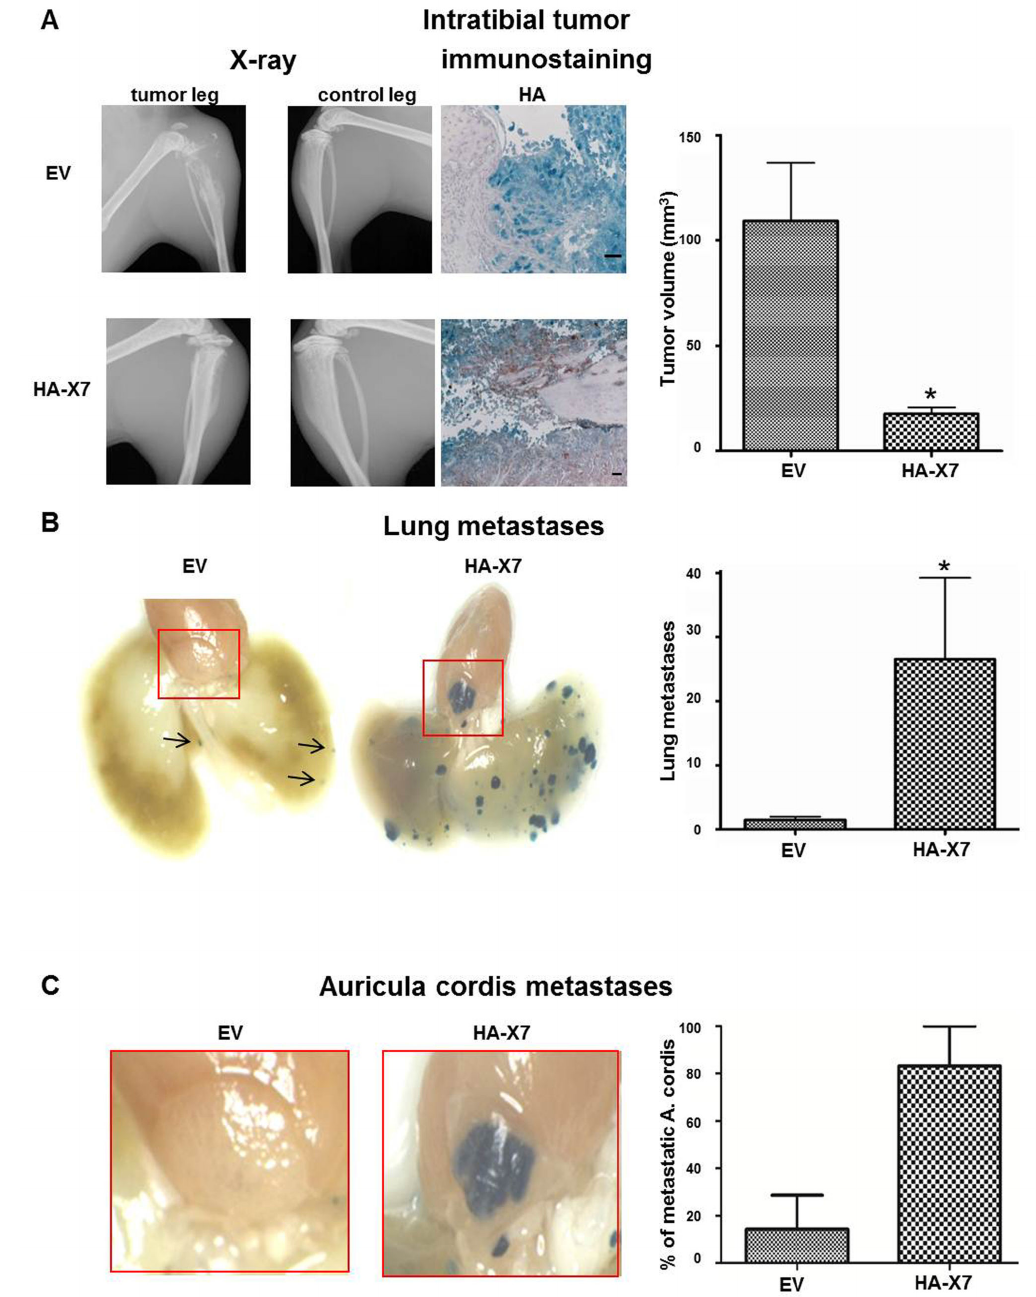
Figure 3. Overexpression of HA-CXCR7 in 143B- LacZ cells diminished primary intratibial tumor growth, but promoted metastasis to the lung and the auriculum cordis. (A) Representative X-ray images of a tumor cell injected leg (tumor leg) and of the contralateral non-injected leg (control leg) of mice injected with 143B- LacZ -EV (EV) cells or with 143B- LacZ -HA-X7 (HA-X7) cells at day 27 after tumor cell injection and representative HA immunohistochemical staining of HA-CXCR7 on sagittal sections of EV and HA-X7 cell injected tibiae and mean calculated volume of intratibial tumors in EV and HA-X7 cell-injected mice at day 27 after tumor cell injection. (B) Representative lung whole mounts with X-gal-stained metastases (blue) obtained from EV (arrows indicate the metastases) and HA-X7 cell injected mice and mean (± SEM) numbers of metastases on the lung surface of respective animals. (C) Whole mounts of auriculum cordis enlarged from (B) with X-gal stained metastatic lesions and mean (± SEM) percentage of mice in indicated groups with auriculum cordis metastatic lesions. Six and 7 mice in the EV and the HA-X7 groups, respectively, were analyzed. *p≤0.05. doi: 10.1371/journal.pone.0074045.g003 PLOS ONE |